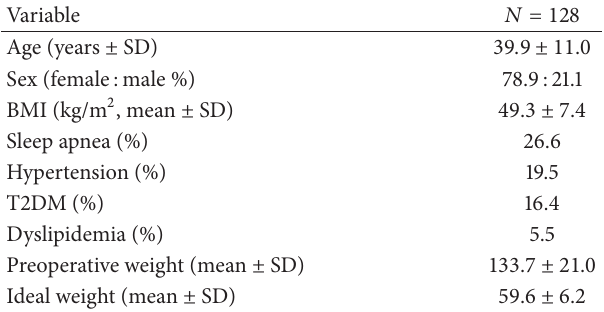
Table 1: Patients’ characteristics at